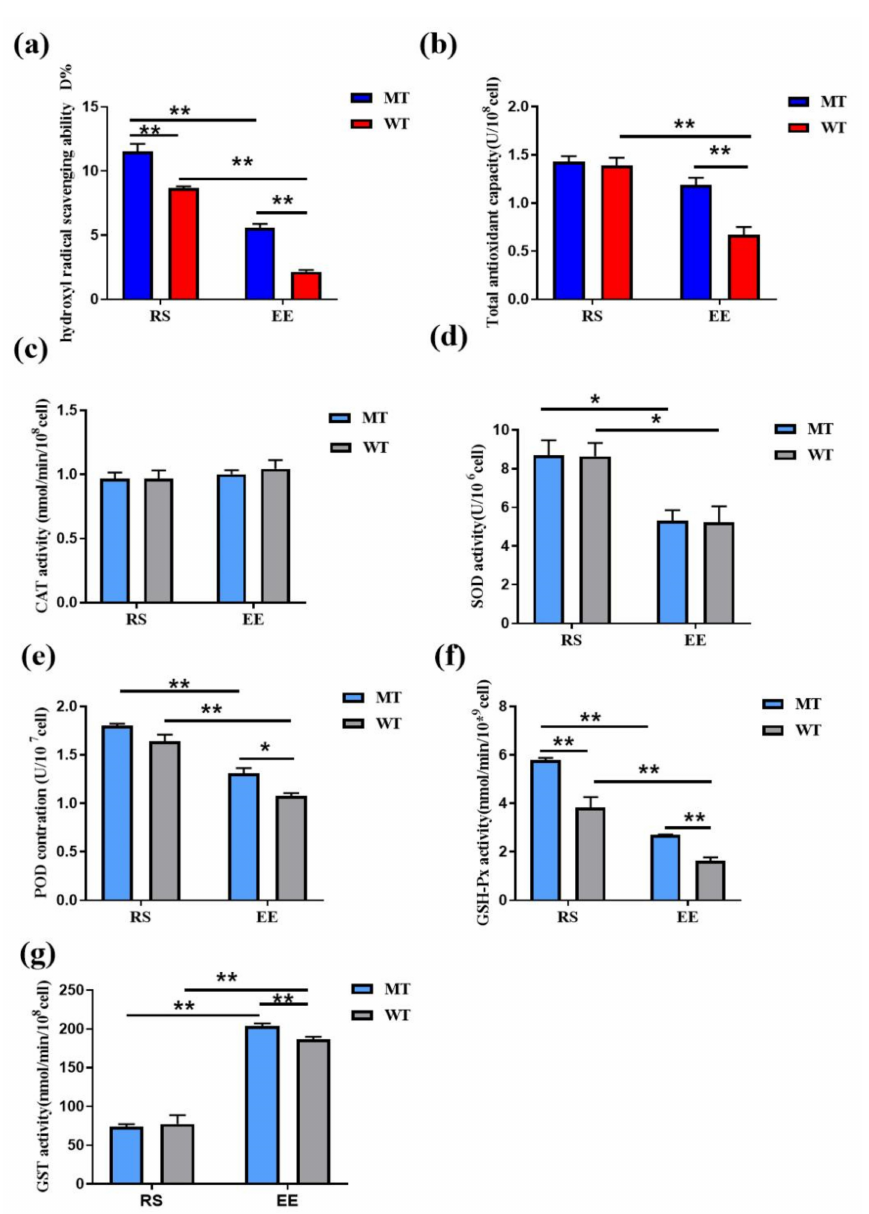
Figure 4. MSTN knockout enhanced the antioxidant capacity of erythrocytes. ( a ) Hydroxyl radical scavenging ability of erythrocytes; ( b ) Total antioxidant capacity of erythrocytes; ( c ) Activity of CAT; ( d ) Activity of SOD; ( e ) Activity of POD; ( f ) Activity of GSH-Px; ( g ) Activity of GST. MT: MSTN knockout cattle group; WT: Wild type cattle group; RS: Resting state; EE: Exhaustive exercise state; Data presented are means ± SD. One-way ANOVA with post hoc LSD multiple-comparison